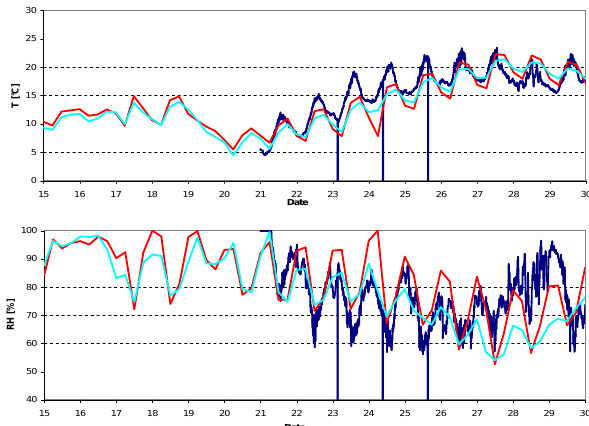
Fig. 2. Meteorological situation at Puy-de-Dôme during June 2010. (a) Temperature [ ◦ C], (b) relative humidity [%]. Dark blue line: measurements, red line: model results first layer, light blue line: model results second layer.